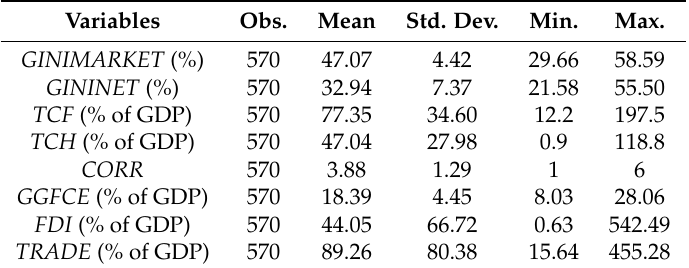
Table 1. Descriptive